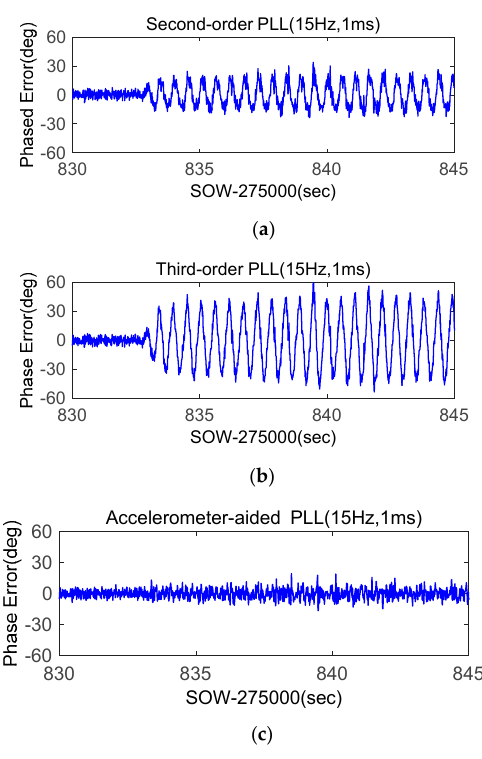
Figure 17. Phase errors of low elevation angle satellite G29 based on shake table tests; ( a ) Phase error of second-order PLL; ( b ) Phase error of third-order PLL; ( c ) Phase error of accelerometer-aided second-order PLL.